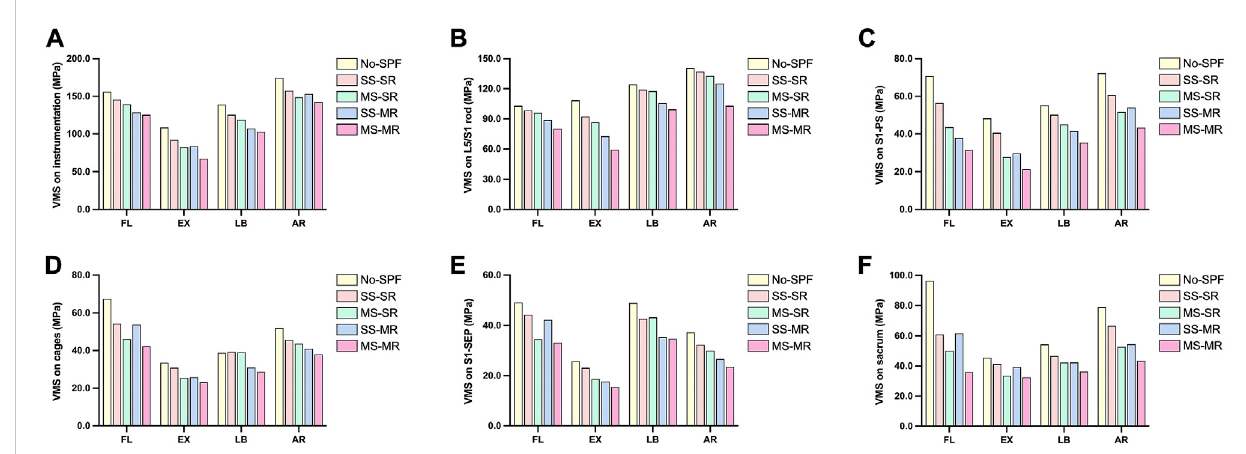
FIGURE 5 Comparison of the maximum von-Mises stress among instrumented models. (A) instrumentation; (B) lumbosacral rods; (C) S1-pedicle screws; (D) cages; (E) S1-superior endplate; (F) sacrum.